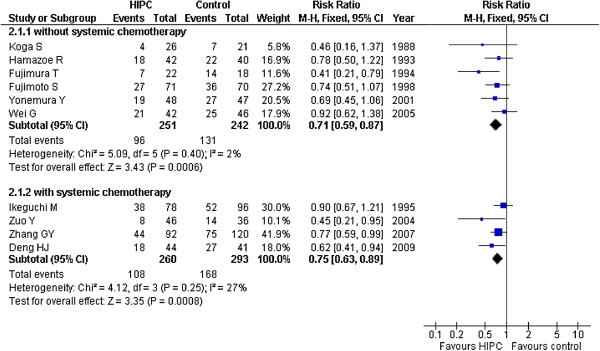
Risk Ratios for overall survival rate of trials with or without systemic chemotherapy.